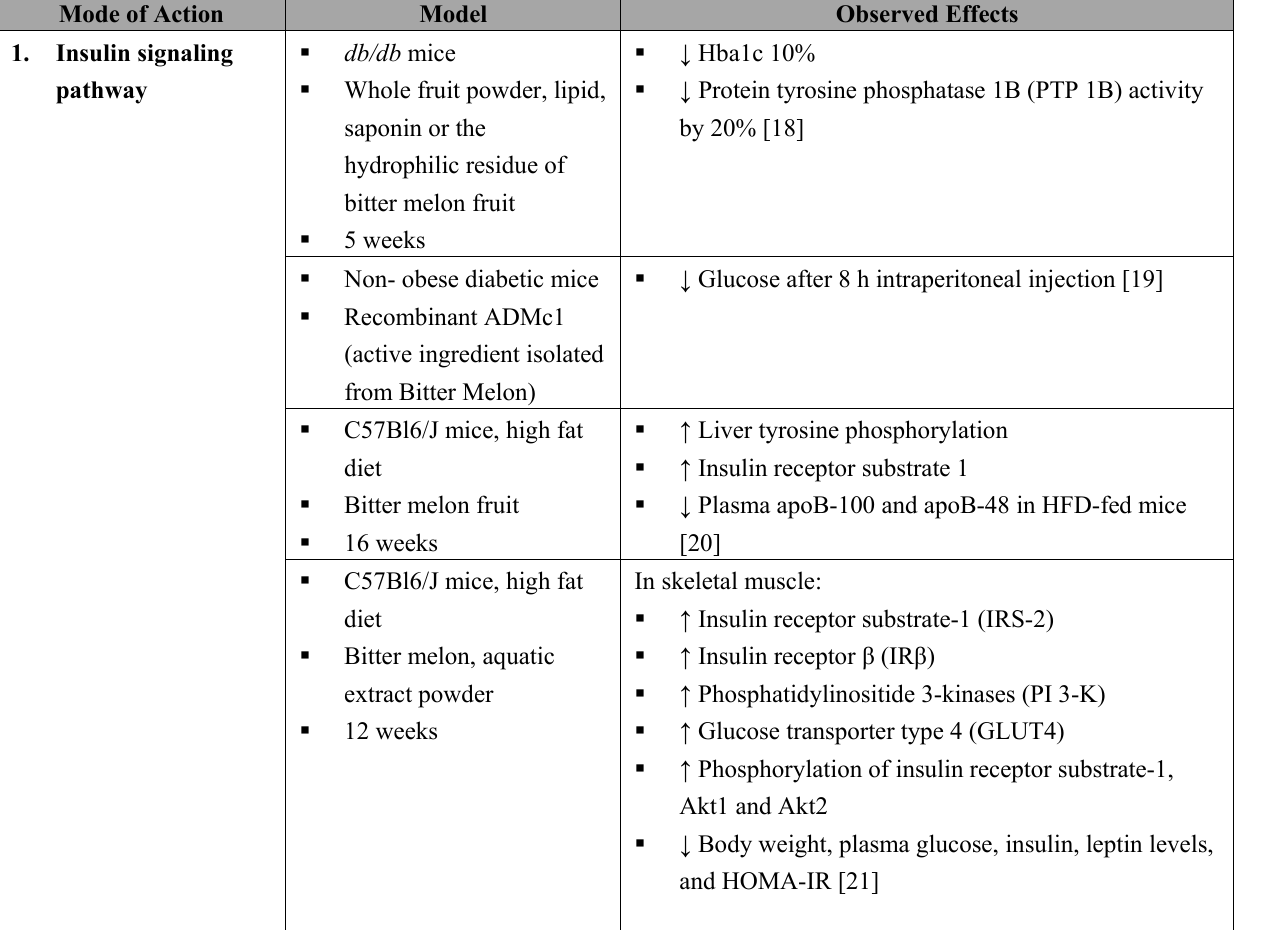
Table 1. Antidiabetic mechanisms of bitter melon ( Momordica charantia ) in animal models. Mode of